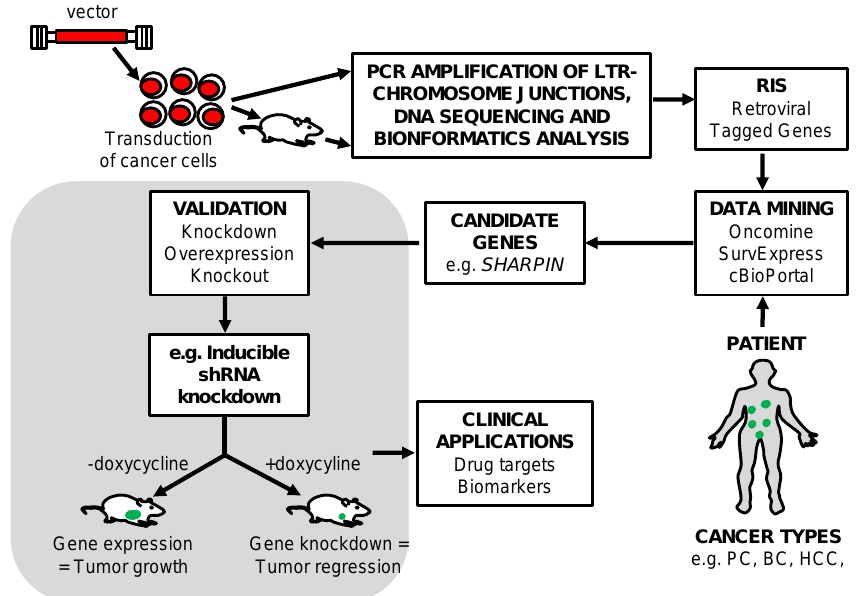
Figure 1. Retroviral insertional mutagenesis screen schematic outline for identification of cancer driver and drug resistance genes. The cancer cells are transduced with retroviral vector, selected and cultured in vitro or xenotransplanted in vivo. The genomic DNA is obtained from tumors or drug resistant clones and the LTR-chromosomal junction determined. High-throughput sequencing and bioinformatics analysis is performed to map the retroviral integration site (RIS) in the genome and identify nearby tagged cancer driver or drug resistant genes. Expression of candidate genes are compared with patient data acquired from publicly available databases and candidate dysregulated gene identified. Candidate driver genes are independently validated to show their involvement in tumor initiation, progression, or drug resistance. PC (prostate cancer), BC (breast cancer) and HCC (hepatocellular carcinoma).